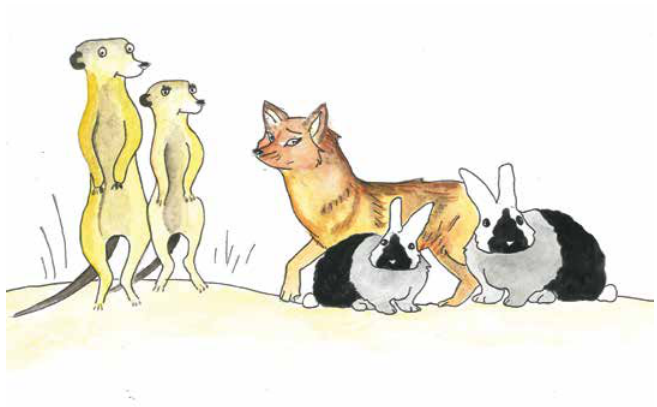
Figure 1: Animal characters in the MARKO-D